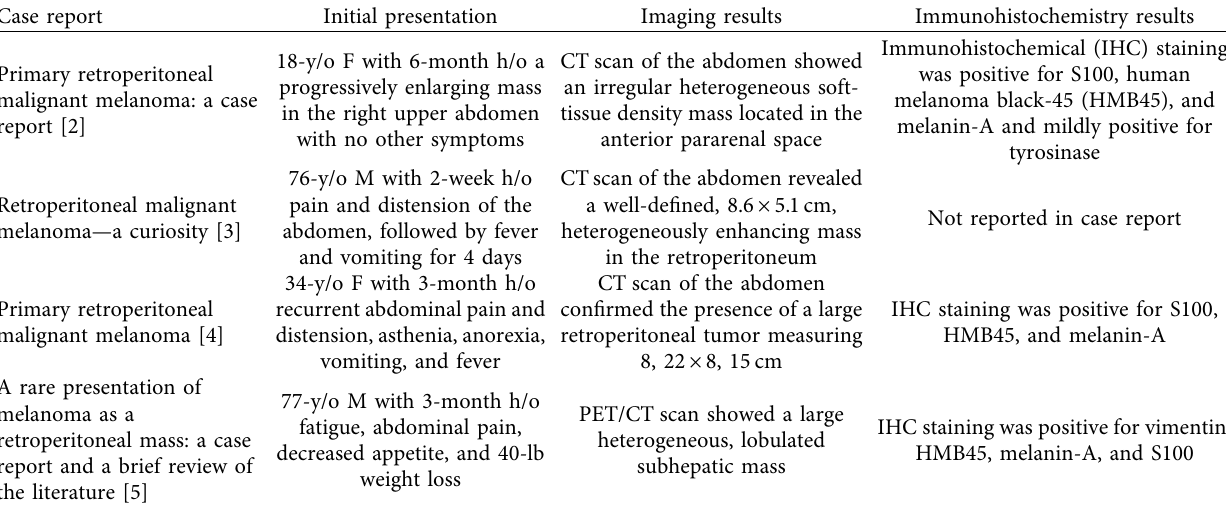
Figure 3: (a) Nest of tumor cells showing areas of necrosis (H&E, original magnification × 100). (b) Immunohistochemical stain positive for Table 1: Literature review of other reported cases of